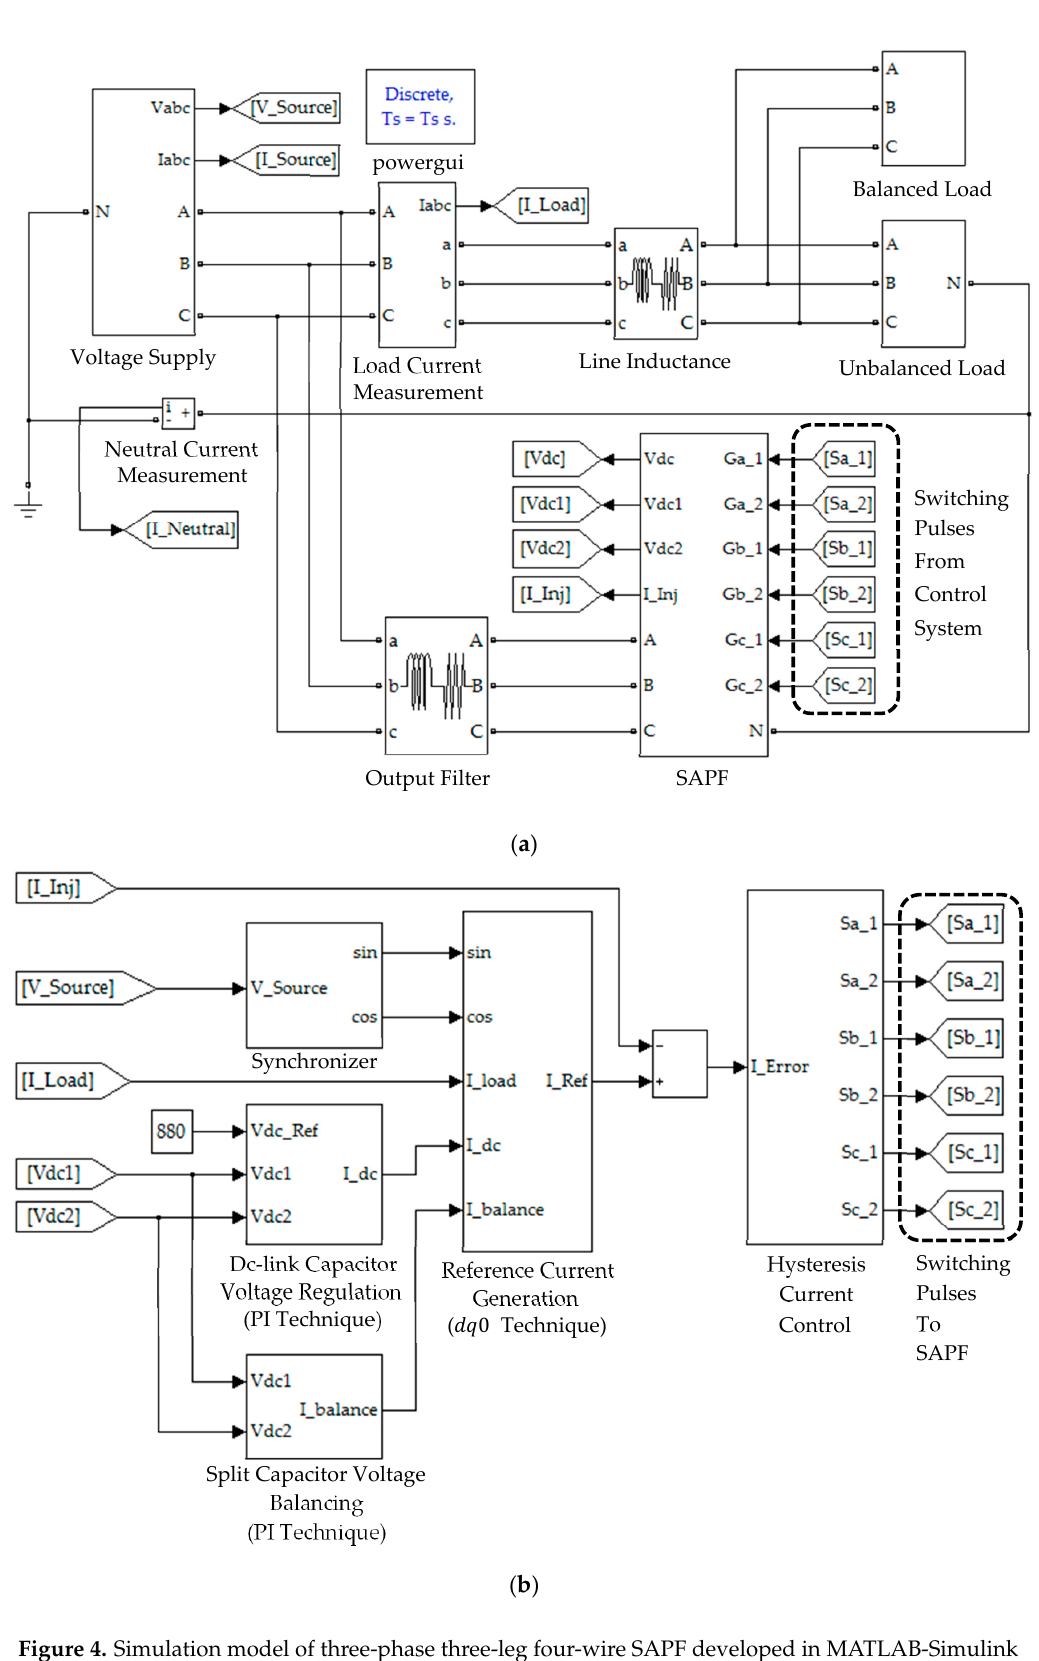
Figure 4. Simulation model of three-phase three-leg four-wire SAPF developed in MATLAB-Simulink platform: ( a ) power circuit arrangement, and ( b ) control system.